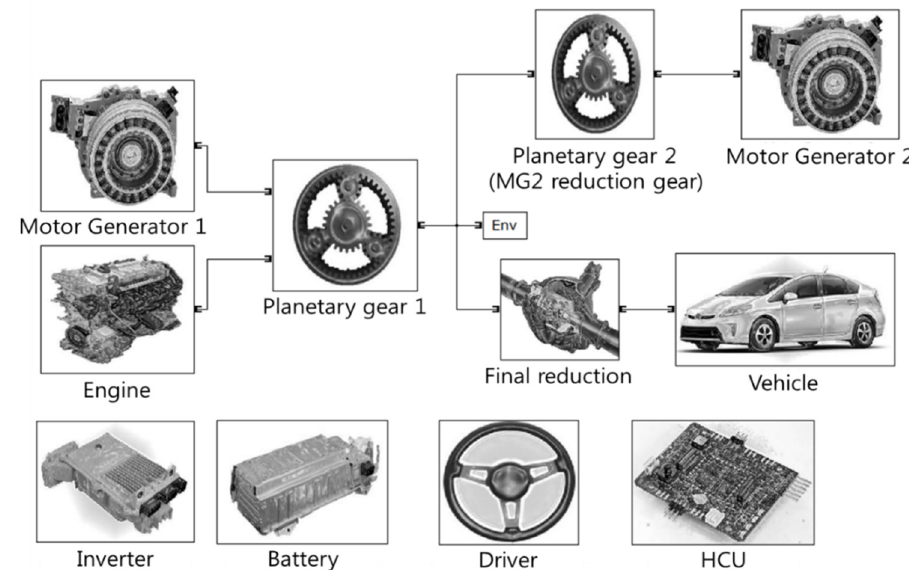
Figure 3. Target PHEV (plug-in Prius) performance